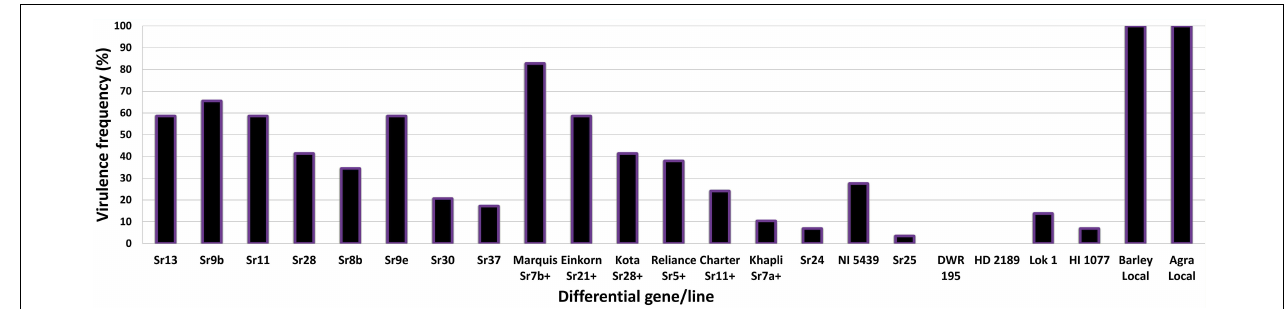
FIGURE 2 | Virulence frequencies (%) of P. graminis f. sp. tritici pathotypes on stem rust